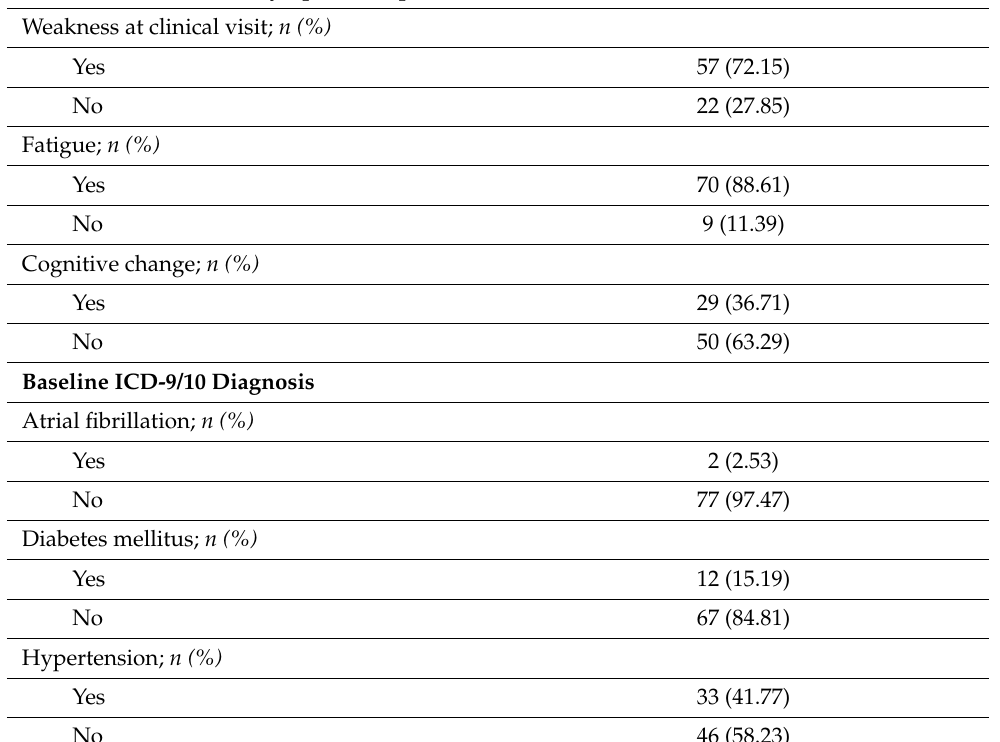
Post-COVID-19 Clinic Symptoms Reported Weakness at clinical visit; n